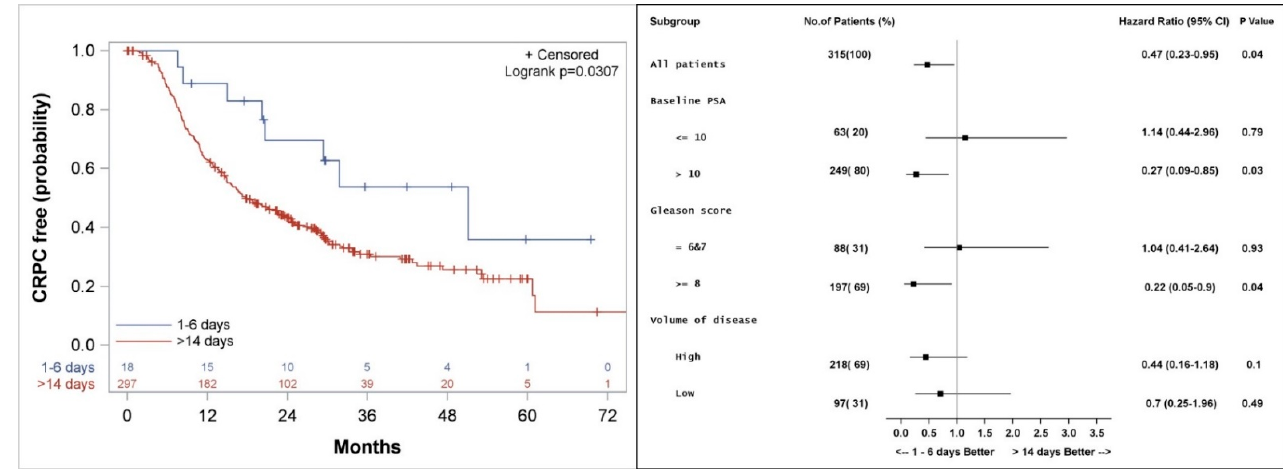
Figure 5. Kaplan–Meier curve ( left ), and subgroup analysis ( right ) for freedom from castrate resistant prostate cancer (CRPC) for patients who started the first course of docetaxel 1–6 days, compared to more than 14 days after the initiation of LHRH agonist.